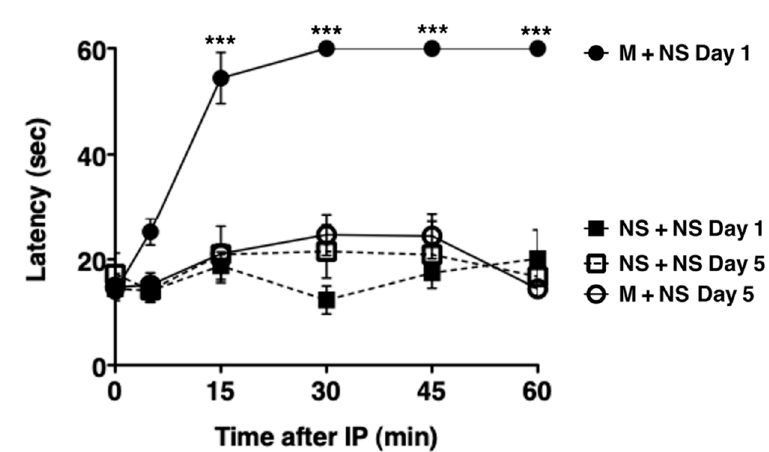
Figure 1. Tolerance development in mice following repetitive morphine intake. Mice received intraperitoneal morphine (M, 20 mg/kg) and oral saline (NS, 300 µL) twice a day for 5 days. IP